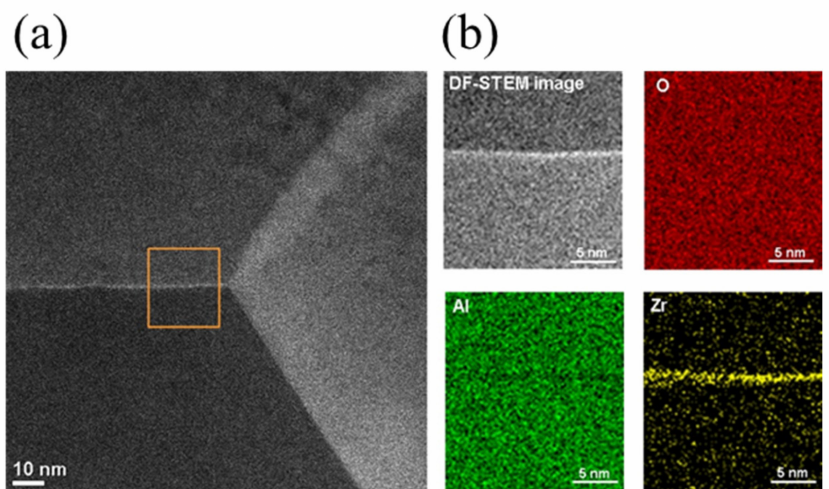
Figure 42. Morphology and element mapping of grain boundaries in Zr-doped Al 2 O 3 . ( a ) STEM image of a triple junction; ( b ) DF-STEM image and STEM-EDXS elemental mapping of the selected GB area [298]. Figure 42 reprinted from Journal of the European Ceramic Society, 35, Martin Trunec, Karel Maca, Radim Chmelik, Polycrystalline alumina ceramics doped with nanoparticles forincreased transparency, 1001–1009, Copyright (2014), with permission from